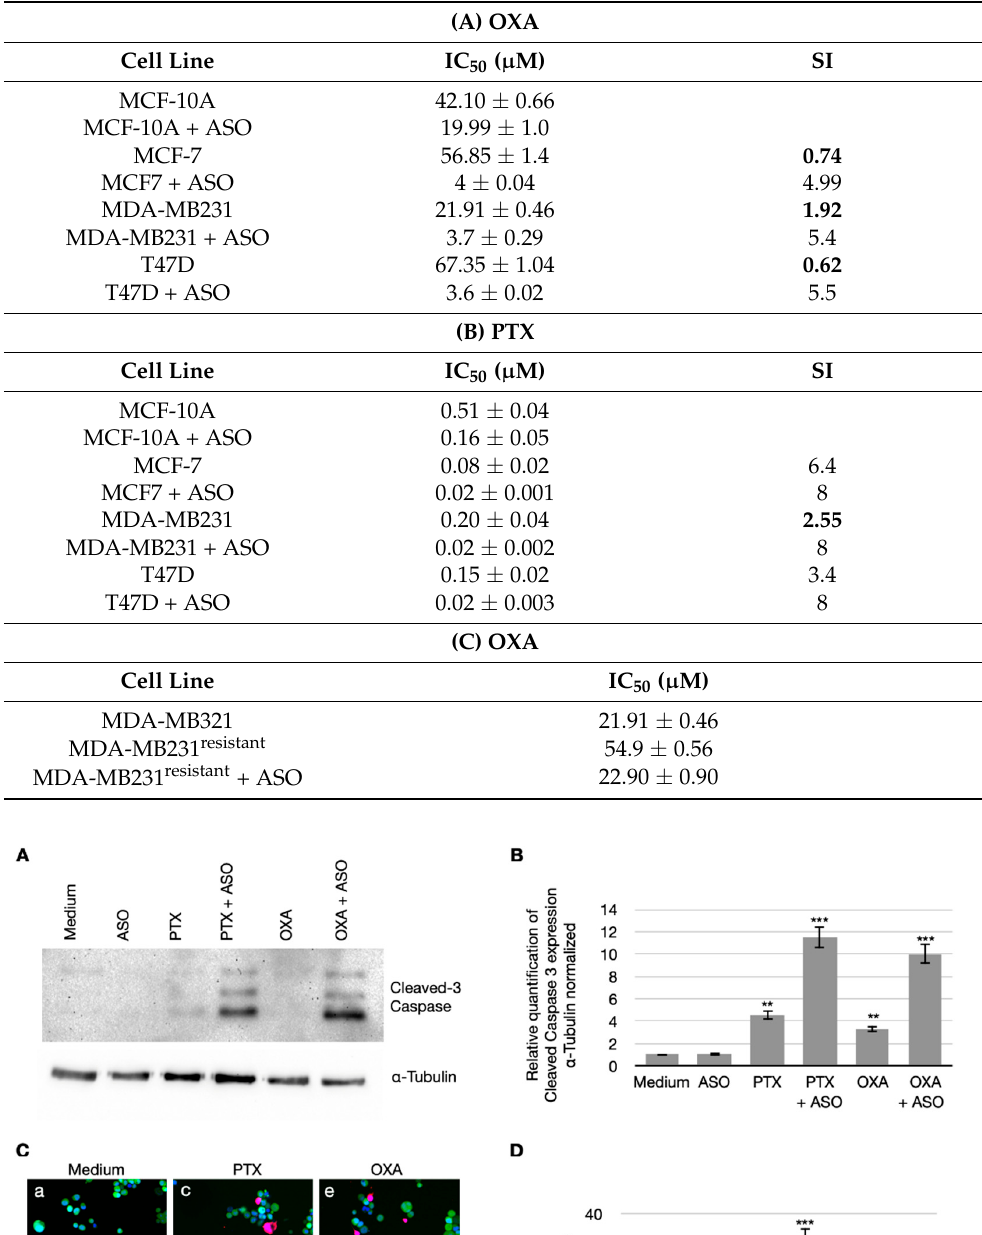
Table 1. ( A – C ) Tables of IC 50 ± SD (half maximal inhibitory concentration ± SD) values for all the compounds were expressed in µ M unit. SI (Selectivity Index) was calculated as a ratio of IC 50 (non-tumorigenic cell line)/IC 50 (cancer cell line). In bold were SI < 3, indicating that the drug is not cancer selective.